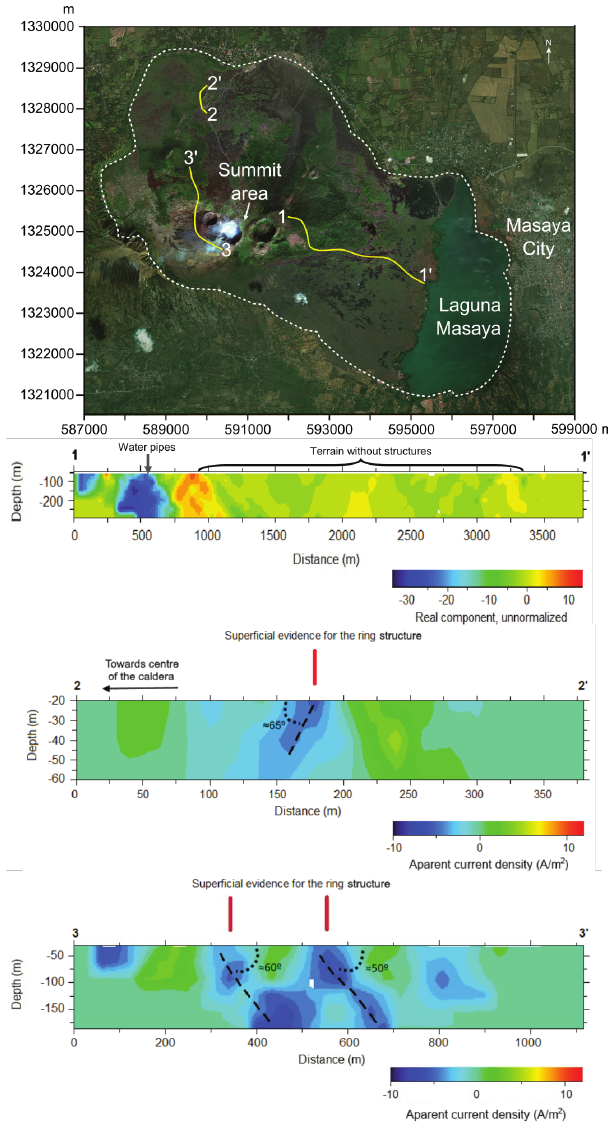
Figure 7: VLF profiles showing several artificial and natural features on the floor of Masaya caldera.